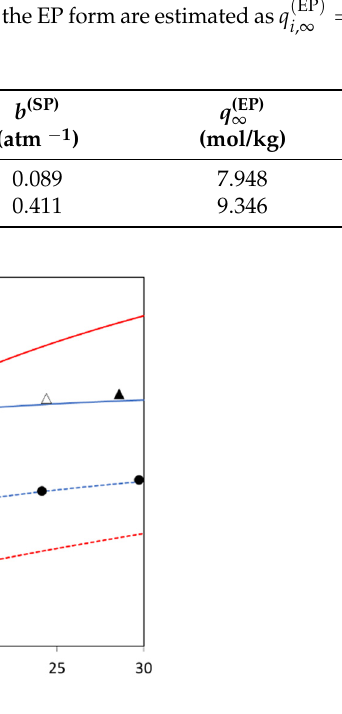
Table 2. Fitting of the Langmuir adsorption isotherm model to the CH 4 and N 2 experimental adsorption data at 273 K. The parameters for the EP form are estimated as q